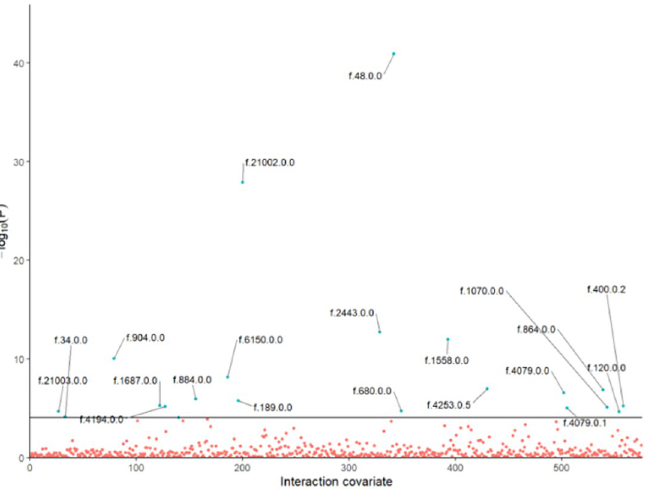
Fig 6. Identified gene-by-covariate interactions with respect to genetically predicted body mass index. A scatter plot showing the first-stage F-statistics for instrument-by-covariate interactions using data from UK Biobank. A horizontal line is included representing the Bonferroni correction for statistical significance. For clarity, blue points represent interactions identified after multiple testing. The 20 strongest interactions have been annotated using their UK Biobank field identification